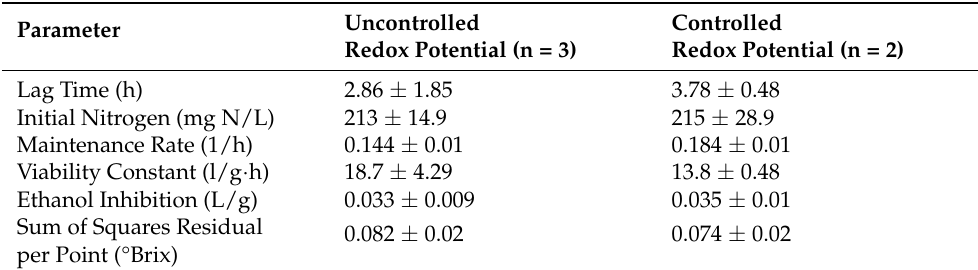
Table 4. Fermentation parameters of uncontrolled and controlled redox potential fermentations, 100 L